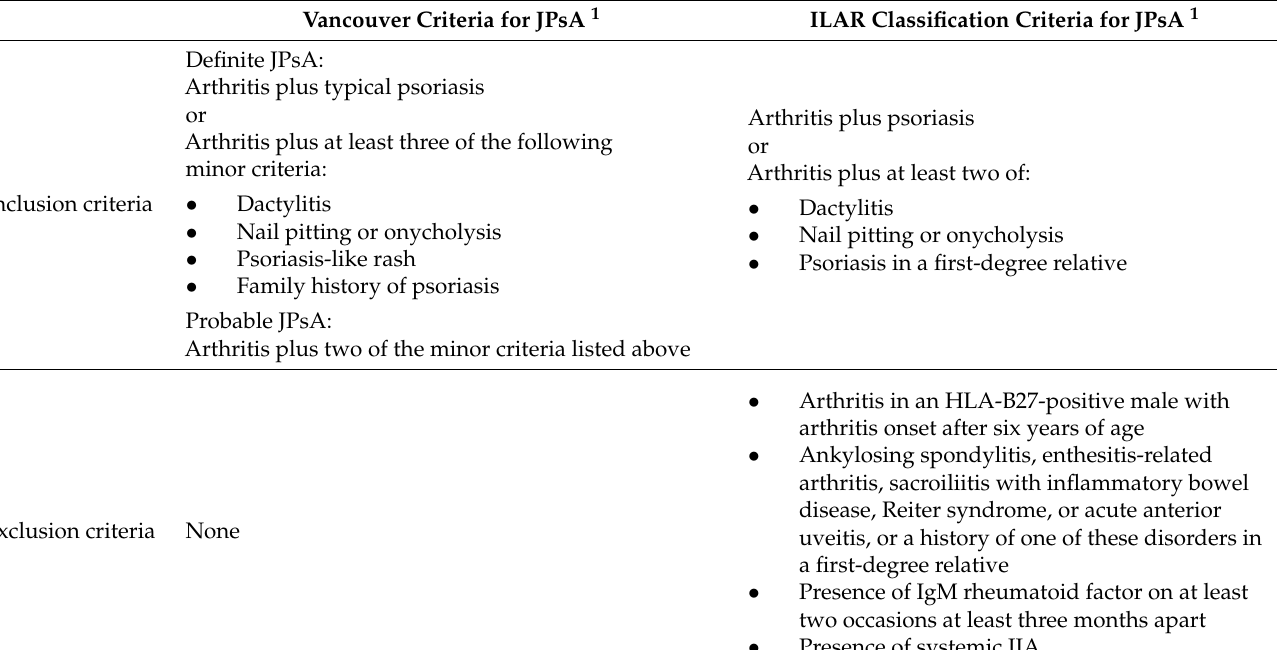
Table 2. Vancouver and ILAR classification criteria for JPsA (adapted from ref.